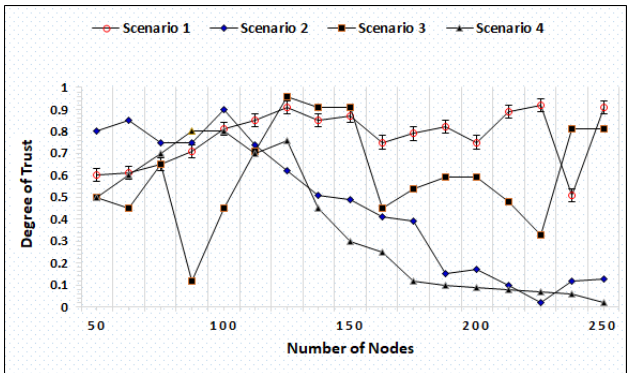
Figure 13. Comparison of AgriTrust against on-off